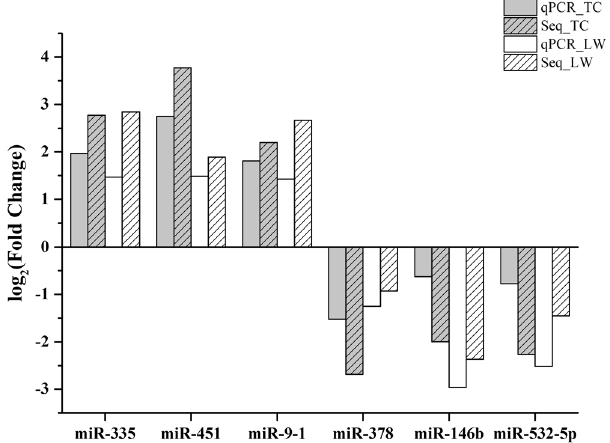
Figure 2. Log 2 (FC) obtained from stem-loop qRT-PCR and small RNA-seq data. x -axis is the name of selected DEmiRNA and y -axis is the value of log 2 (FC).